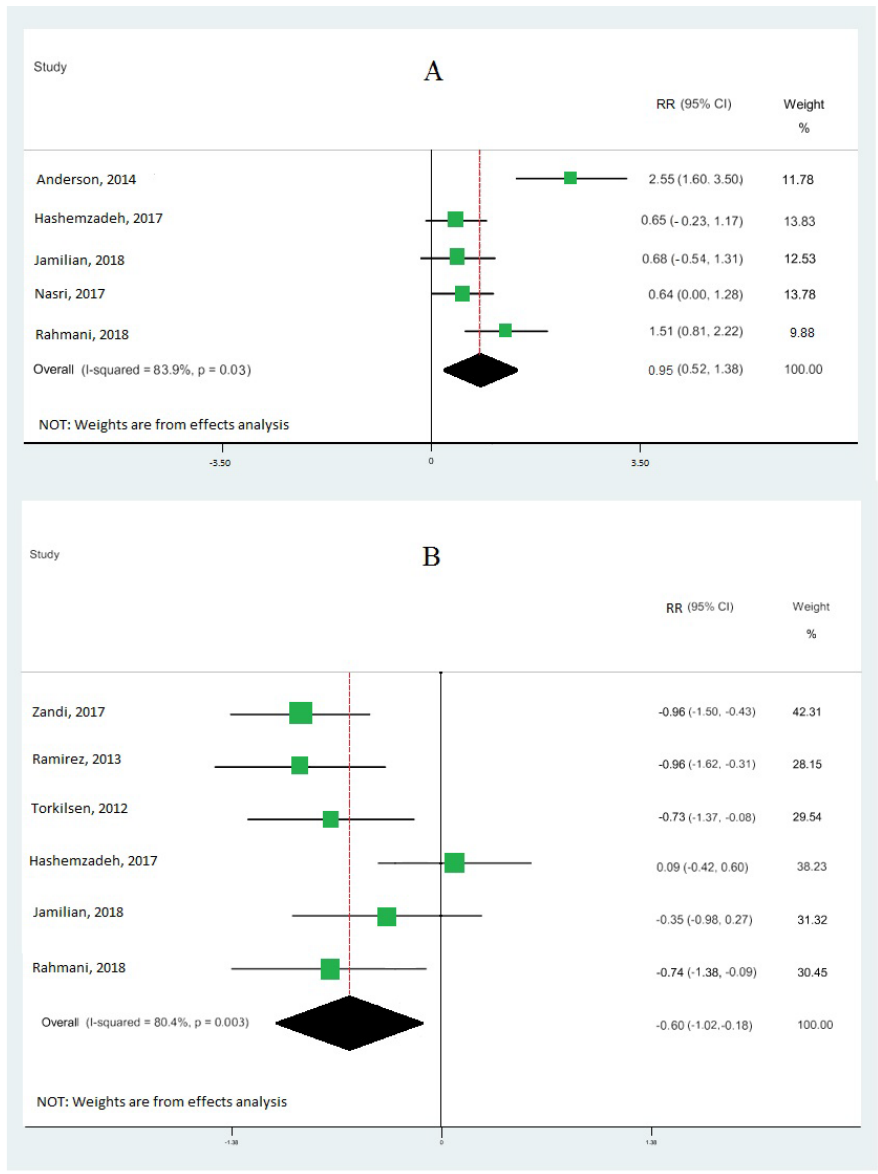
Figure 2. Pooled RRs of gene expression of inflammation according to interquintile range (difference between 90th and 10th percentiles) of the highest vs. lowest omega-3 effects: peroxisome proliferator-activated receptor gamma (PPAR- γ ) ( A ) and interleukin-1 ( B ). RR and 95% CI are abbreviations of the relative risk and 95% confidence interval, respectively [10,19,33–38].